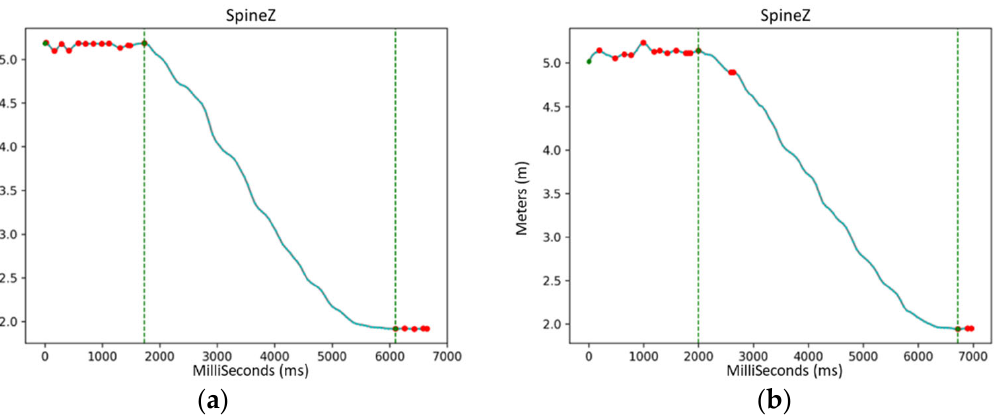
Figure 5. SANE’s detection of movement’s start and stop (green vertical lines) through the projection on Z of the signal related to the Spine joint and its relative maxima and minima (red dots): ( a ) a low-noise acquisition while walking; ( b ) a different, slightly noisier acquisition with a maximum and a minimum that are correctly ignored during the gait recognition and the start and stop evaluation.